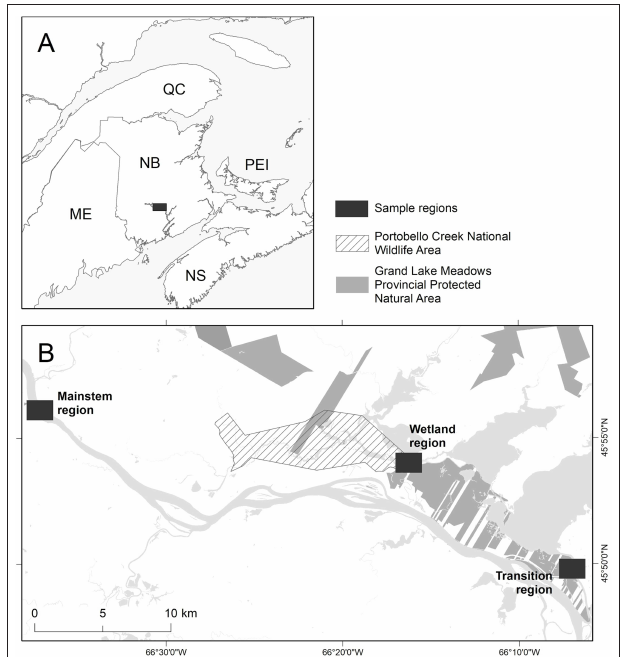
FIGURE 1 | Map of the study area. (A) The Grand Lake Meadows complex, located in southern New Brunswick, is Atlantic Canada’s largest freshwater wetland. (B) This complex is protected both nationally (diagonal lines) and provincially (light gray). Our study area consisted of three distinct regions (dark gray): the wetland (Wetland), the mainstem Saint John/Wolastoq River (Mainstem), and the Jemseg River (Transition), which connects the wetland to the mainstem region. Within each region, six sites were sampled three times (early June, early September, and